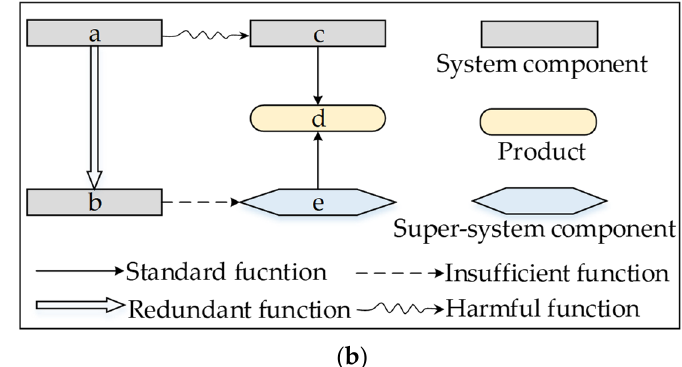
Figure 10. ( a ) Interaction matrix of system components, products, and super-system components; ( b ) Function model.